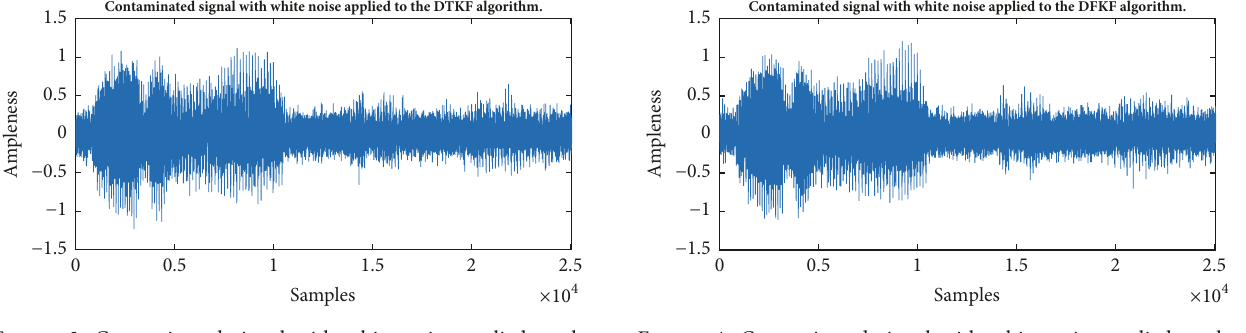
Figure 2: Contaminated signal with white noise applied to the DTKF algorithm.